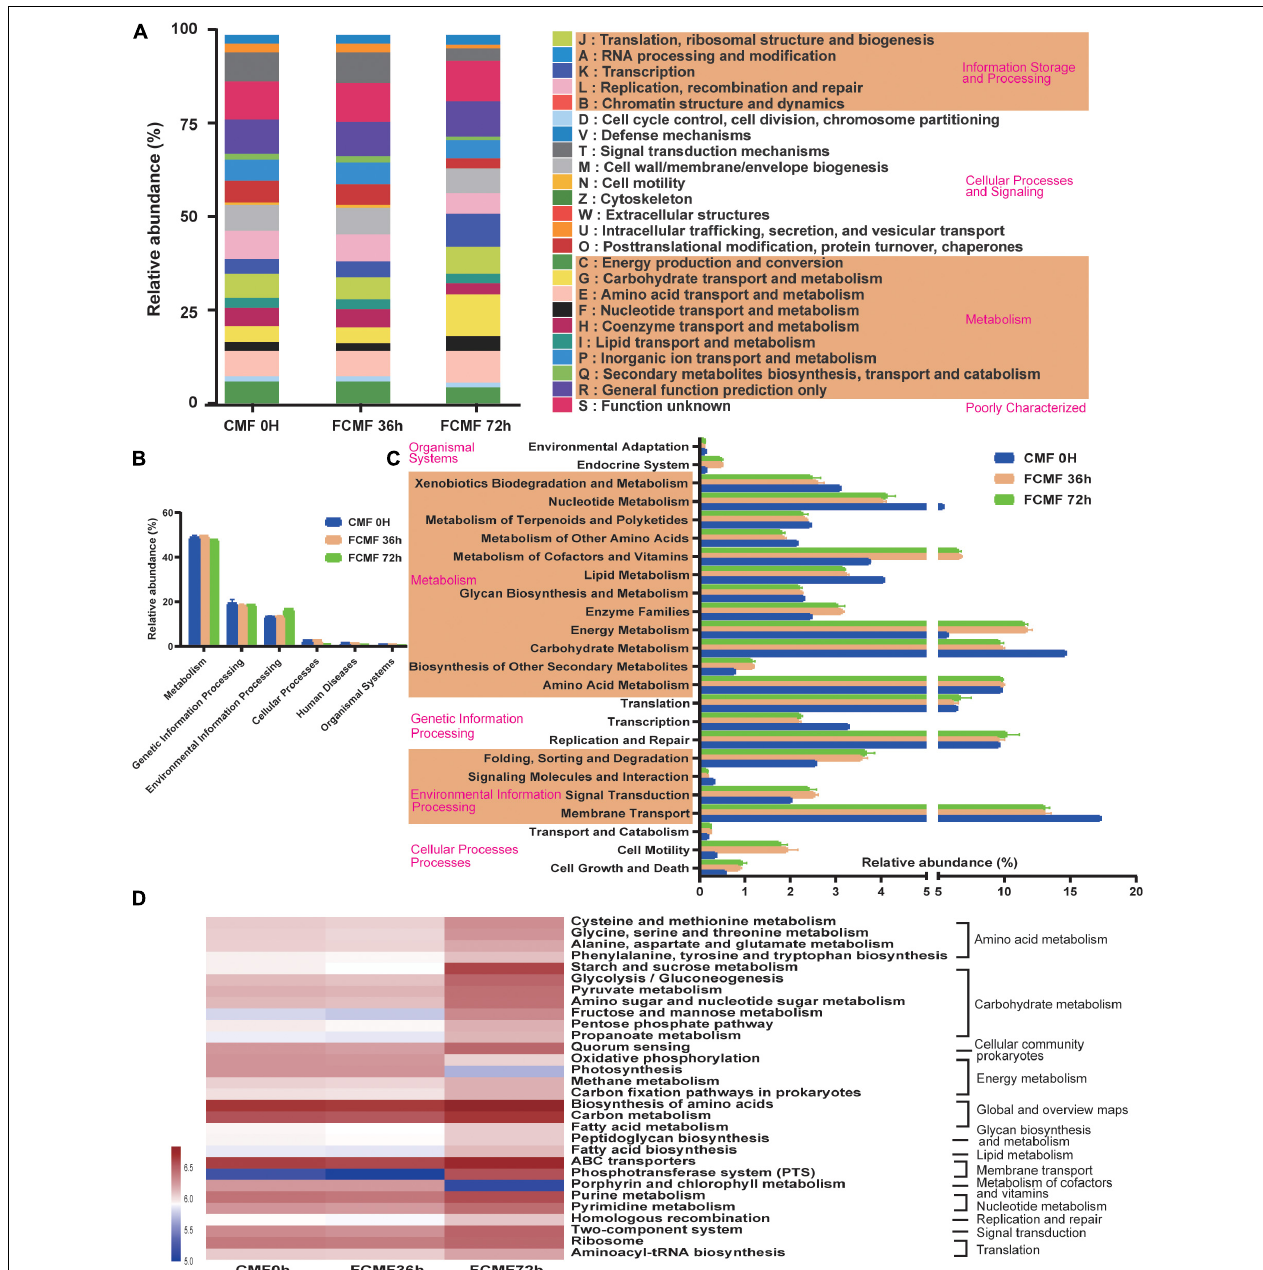
FIGURE 5 | Dynamics of bacterial functional profiles during CMF fermentation process analyzed by PICRUSt ( n = 3). (A) Clusters of Orthologous Groups of protein (COG) function classification. (B) Level 1 metabolic pathways. (C) Level 2 Kyoto Encyclopedia of Genes and Genomes (KEGG) ortholog functional predictions. (D) Level 3 KEGG ortholog functional predictions of the relative abundances of the top 30 metabolic